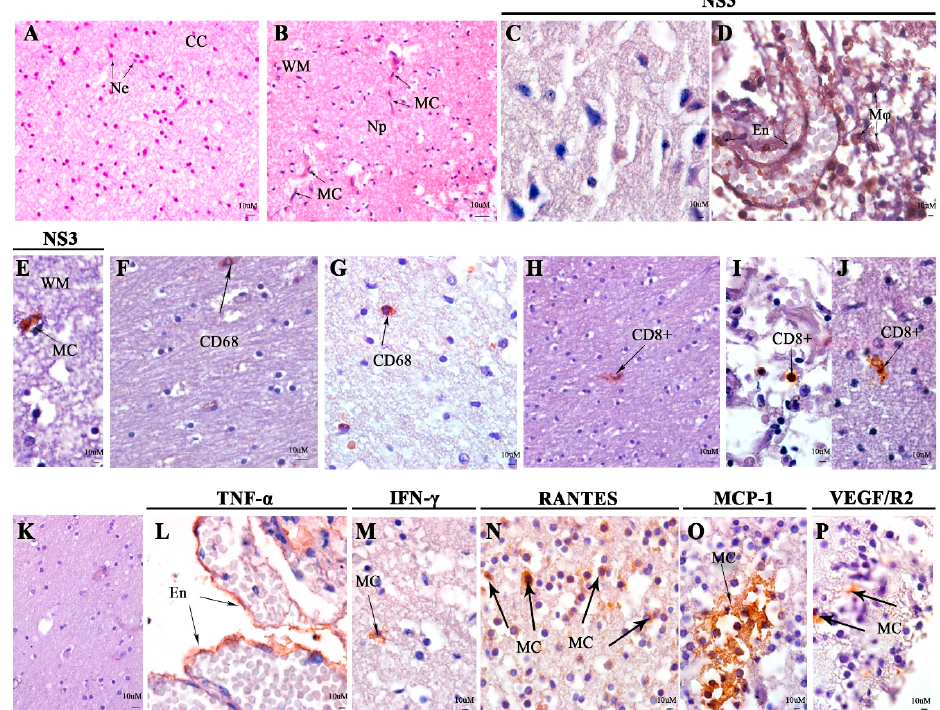
Figure 1. Histopathological and immunohistochemistry analysis of the fetal brain. ( A ) Brain of a non-DENV case presenting normal aspect: cerebral cortex (CC) and neurons (Ne). ( B ) White matter (WM) region of the stillborn brain presenting neuropile (Np) and microglial cells (MC). ( C ) DENV NS3 staining by immunohistochemistry in negative control. ( D ) DENV NS3 protein present in circulating macrophages (Mø) and endothelial cells (En) in blood vessels in the meningeal region and ( E ) microglial cells (MC) in WM. CD68 detection in negative control ( F ) and DENV case ( G ). CD8 + T cell detection in vessels in negative control ( H ), meningel region ( I ) and parenchyma ( J ) both in DENV cases. ( K ) Representative negative control non-DENV of cytokine and inflammatory mediators. ( L ) Endothelial cells (En) TNF- α expressing in DENV-case. IFN- γ ( M ), RANTES ( N ), MCP-1 ( O ), and VEGF/R2 ( P ) expressing in microglial cells (MC) from DENV-case